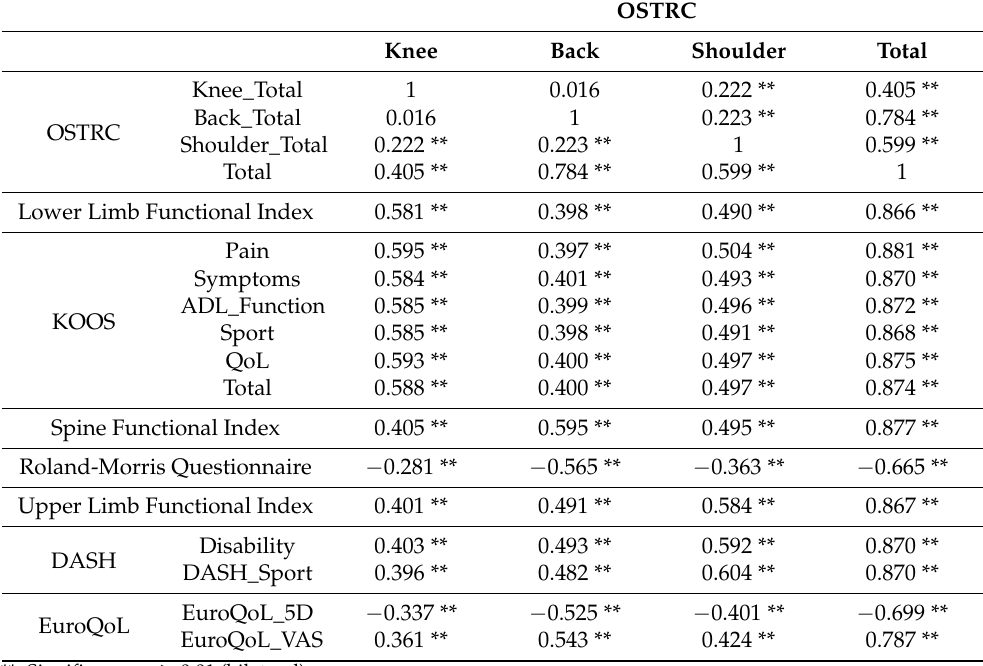
Table 5. Correlation matrix between the total OSTRC-Sp score and all the reference instruments used for criterion validity, as well as their